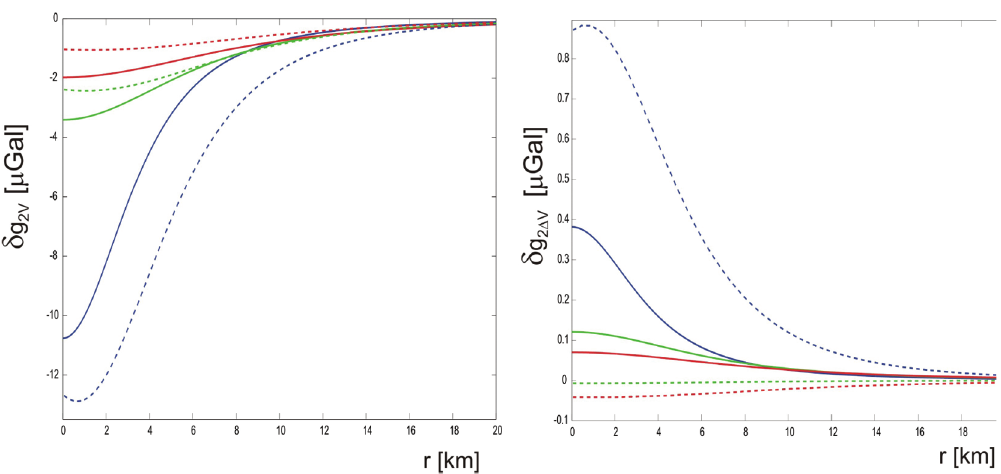
Fig. 6. Numerical (dashed lines) and homogeneous half-space solutions (solid lines) for the δ g 2 ∆ V and δ g 2V gravity contributions whether no mass intrudes into the source, including the topography effect. The increase in the gravity field depends on the depth of the source: 3 km (blue), 6.5 km (green), 9 km